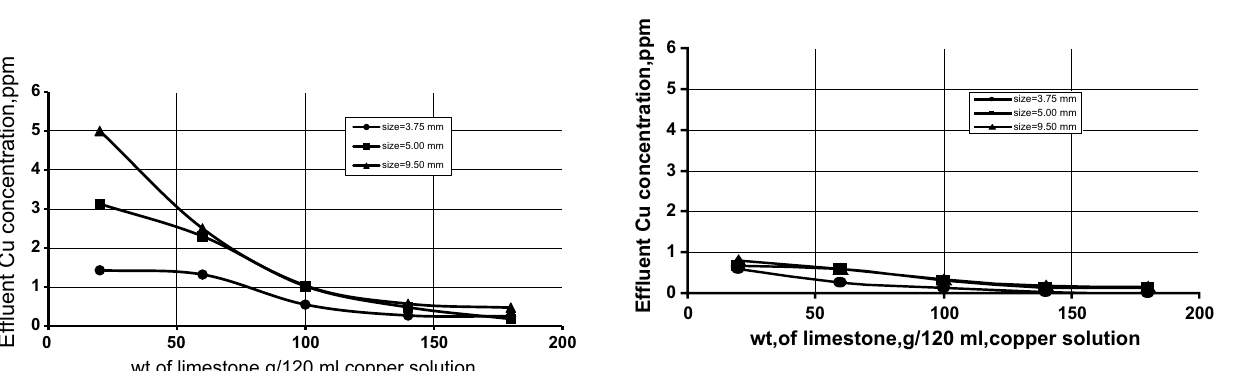
Fig. 3 The effect of volume of limestone on removal efficiency of copper for low influent concentration of copper (1.72 mg/l)